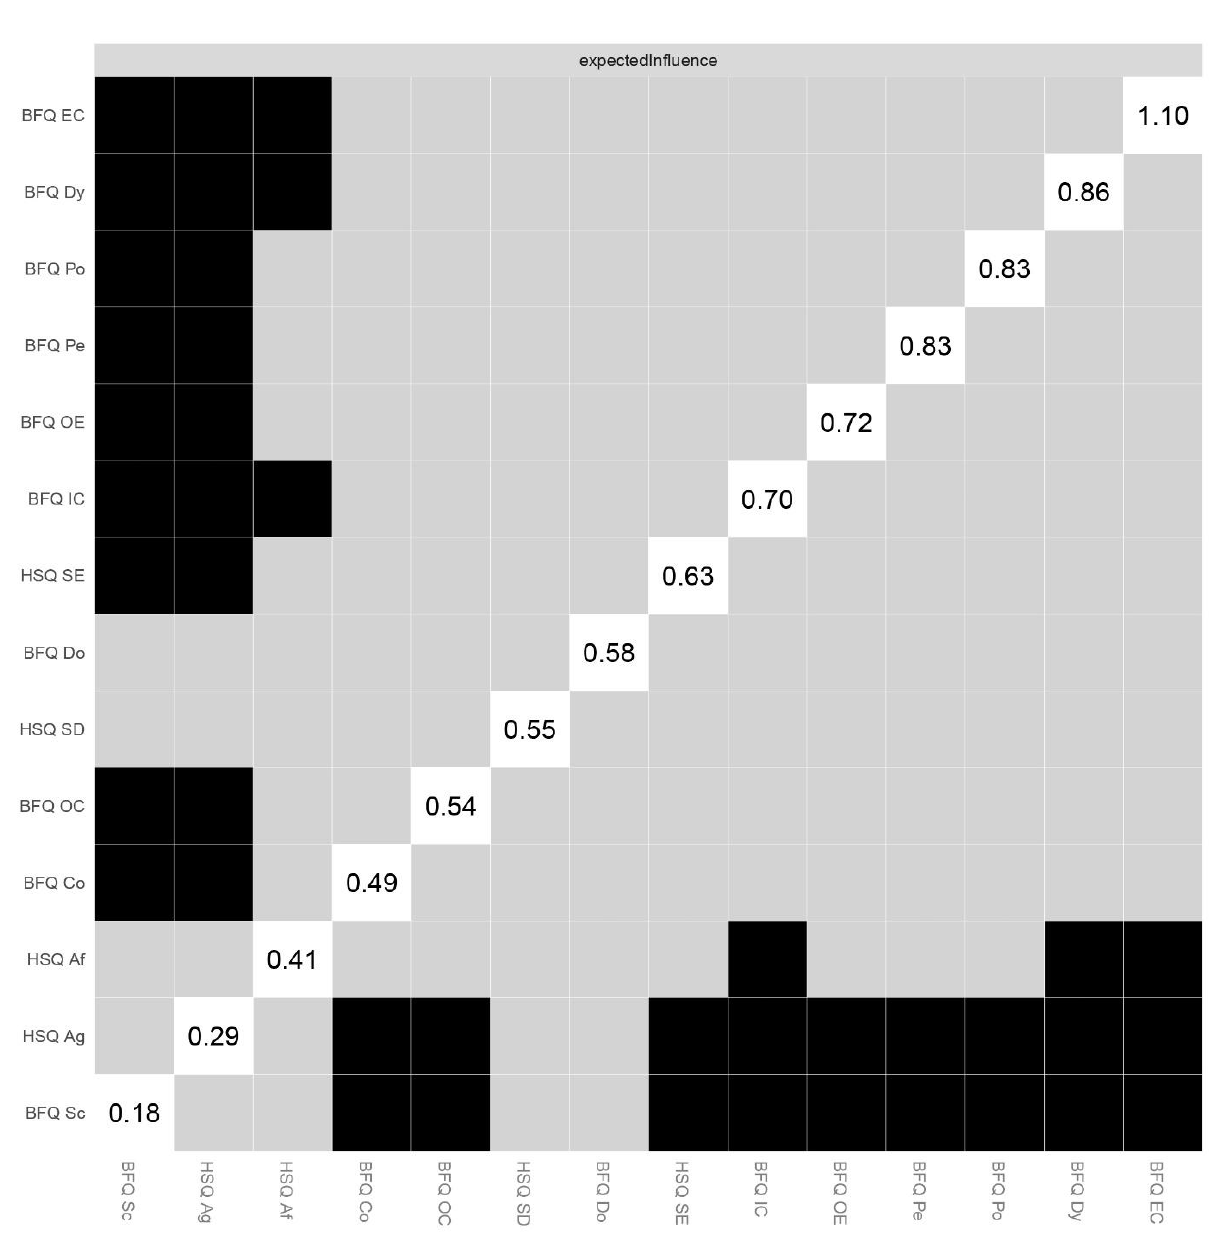
Figure 4. Network of Humor Styles dimensions and Big Five Personality facets ( n = 462): Nonparametric bootstrapped difference test. Note: The Humor Style Questionnaire dimensions and Big Five Questionnaire personality facets are displayed on the X and Y axis. Numbers in withe boxes on diagonal illustrate Expected Influence (EI) centrality estimates (raw score). Black boxes represent a statistical difference between EIs, whereas gray boxes highlight a difference that is not statistically significant. Big Five Questionnaire (BFQ) ten facets. Dy: Dynamism; Do: Dominance; Co: Cooperativeness; Po: Politeness; Sc: Scrupulousness; Pe: Perseverance; EC: Emotion Control; IC: Impulse Control; OC: Openness to Culture; OE: Openness to Experiences. Humor Style Questionnaire (HSQ) four dimensions Af: Affiliative; SE: Self-enhancing; Ag: Aggressive; SD: Self-defeating.